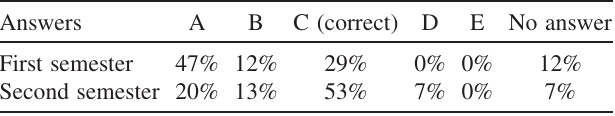
TABLE IV. The answer distributions of 17 graduate students